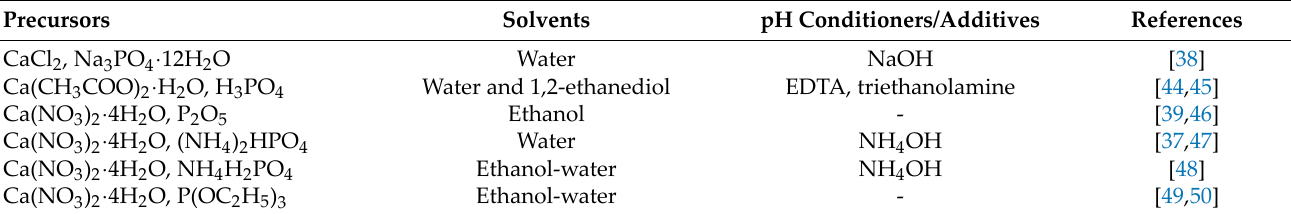
Table 1. Chemical reagents for HAP sol